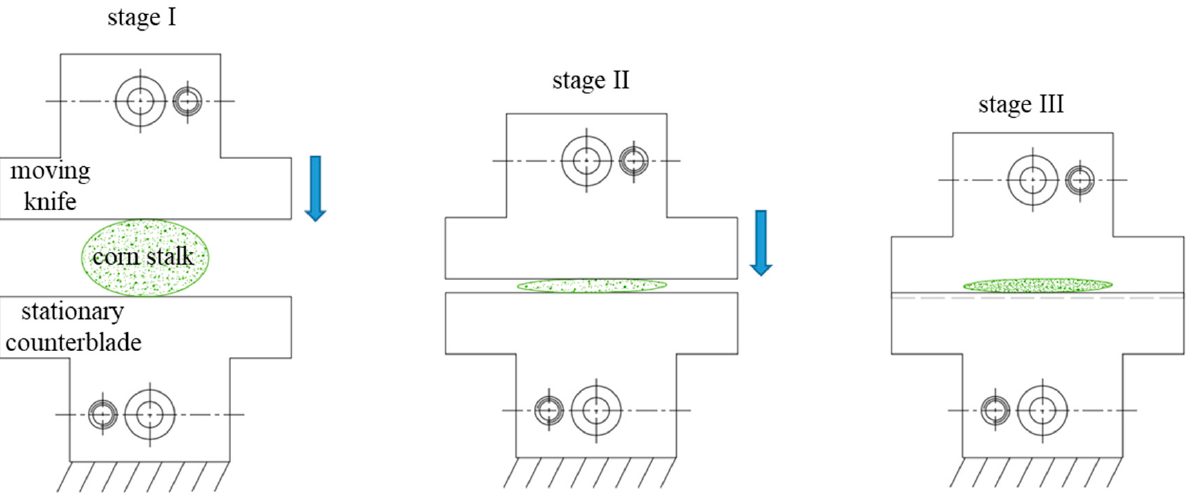
Figure 5. Stages of the corn-stalk cutting process.